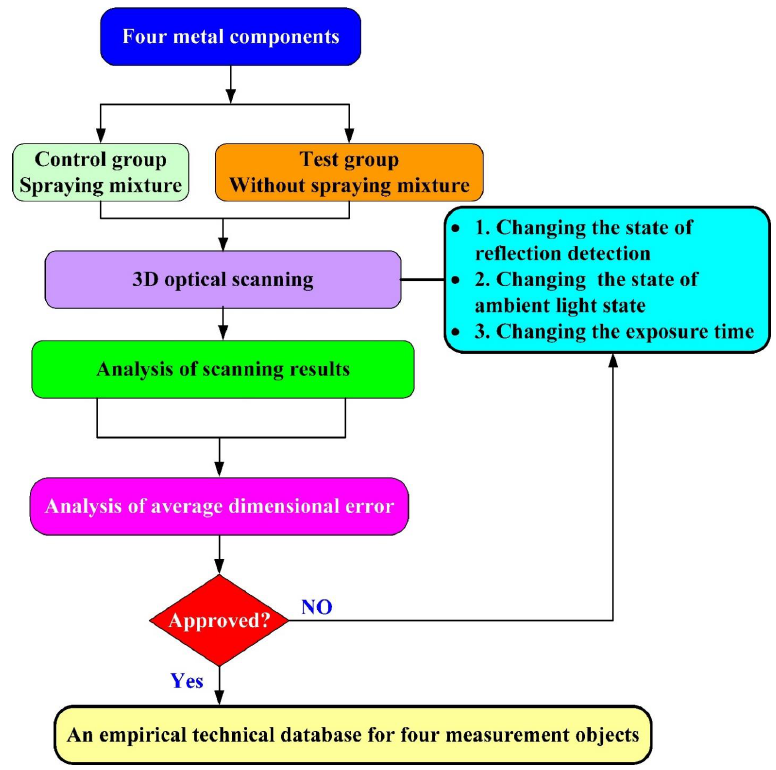
Figure 1. Research process of this study.